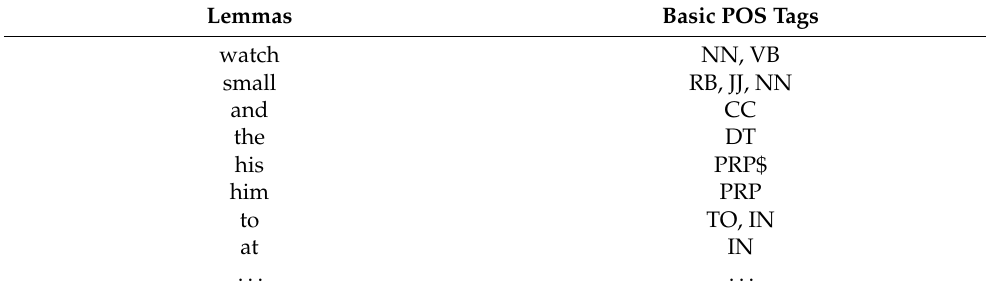
Table 2. The dictionary.